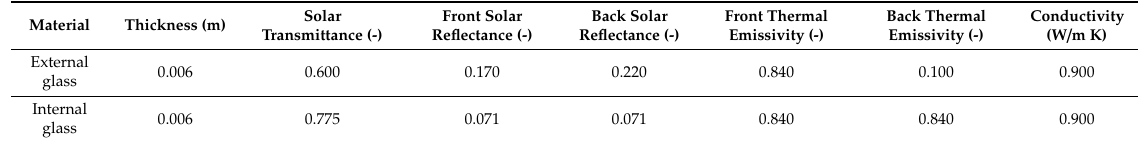
Table 1. Thermo-physical properties of transparent materials.